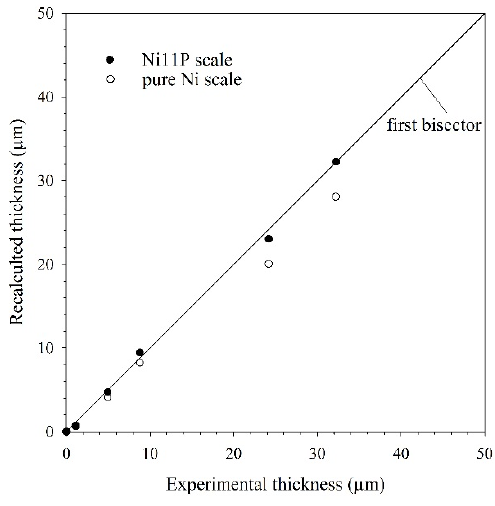
Figure 4. Recalculated thickness (using mass gain) vs. experimental thickness (observed on cross-sectional views) of scales.